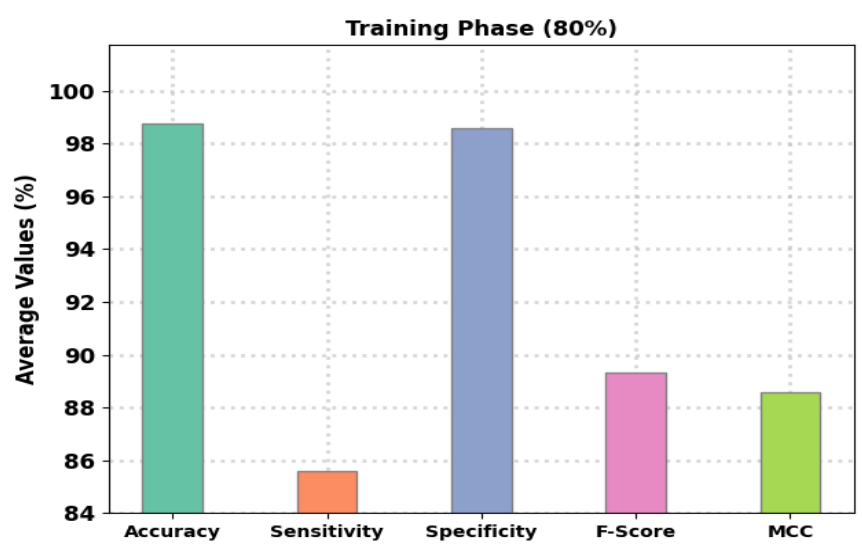
Figure 8. Average analysis of the RFER-EADL algorithm for 80% of the TR dataset.